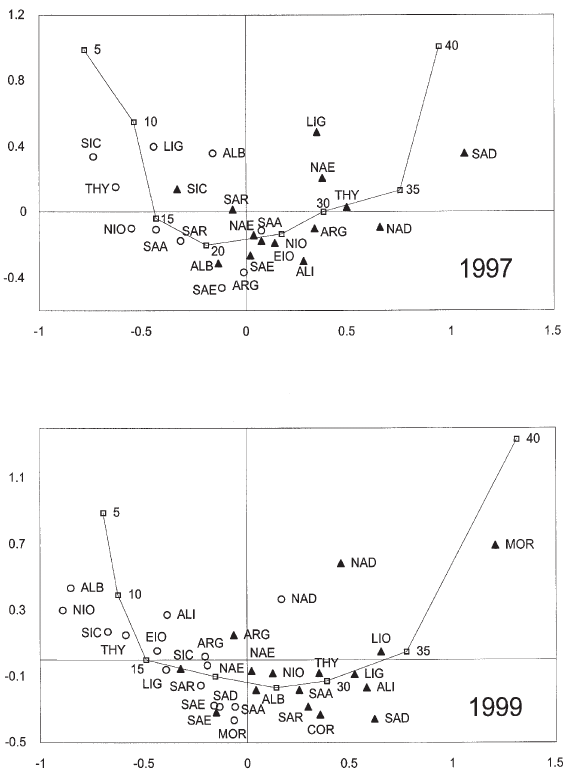
F IG . 6. – Parapenaeus longirostris : Correspondence analysis. Ordi- nation of the samples and size classes as a function of the first two inertia axes. Samples obtained in 1997 and 1999 are presented as an example. Open circles indicate shelf samples; black triangles indi- cate slope samples. Squares correspond to sizes; black circles to samples. ALB: Alborán Sea, ALI: Alicante sector, CAT: